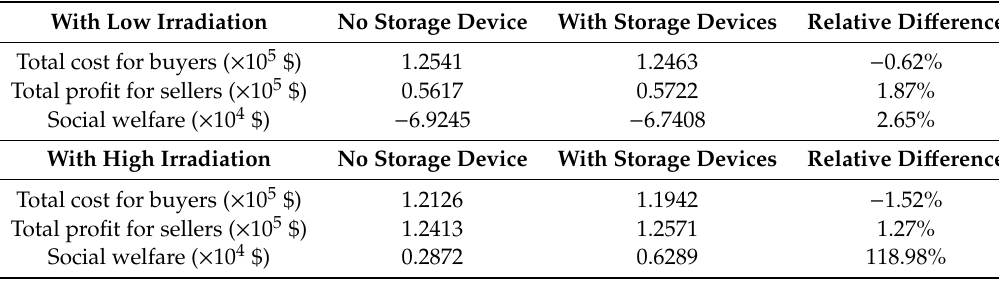
Figure 7. Comparison of the hourly social welfare: ( a ) with low irradiation and ( b ) with high irradiation. Table 1. Summary of the results of two 7 × 24-h